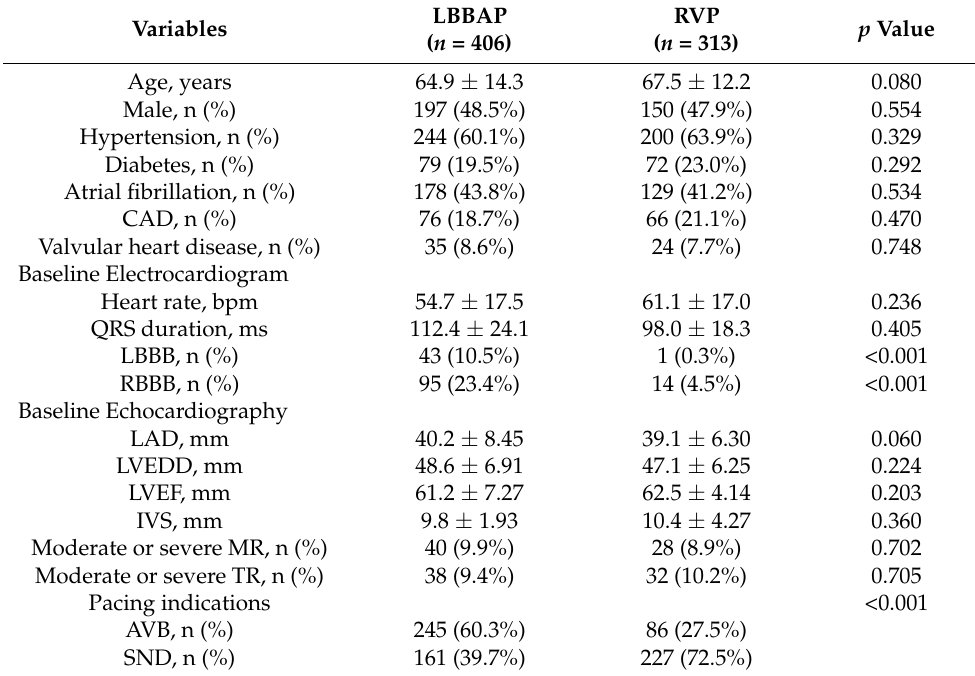
Table 1. Baseline clinical features of patients attempting LBBAP and